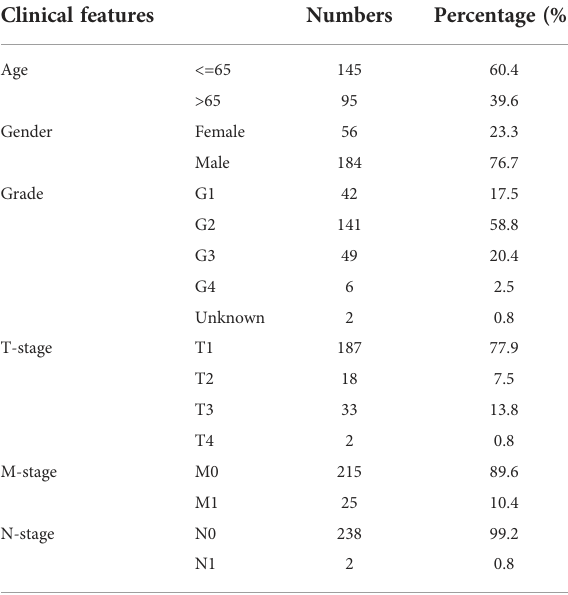
TABLE 2 Baseline information of patients in E-MTAB-1980.